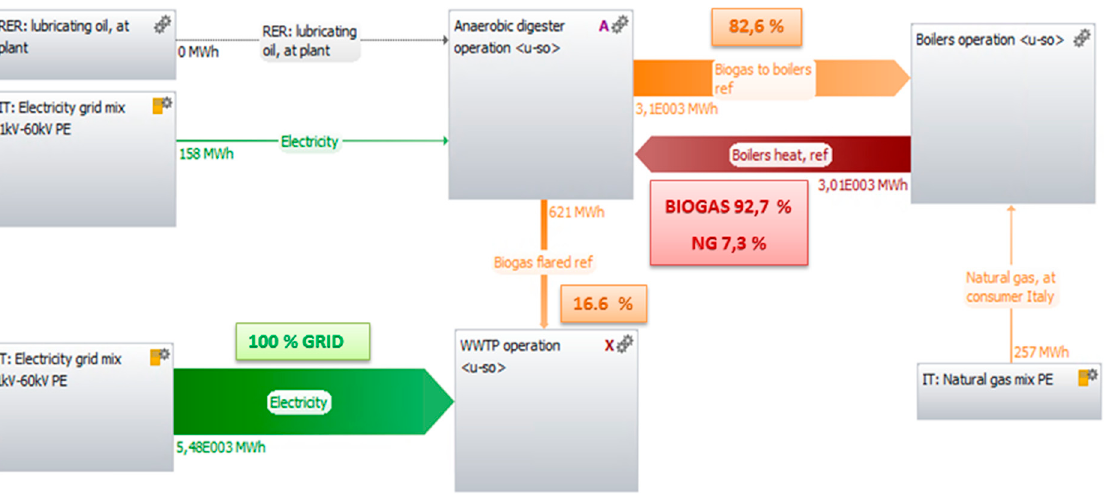
Figure A1. Energetic flows in Scenario 1.